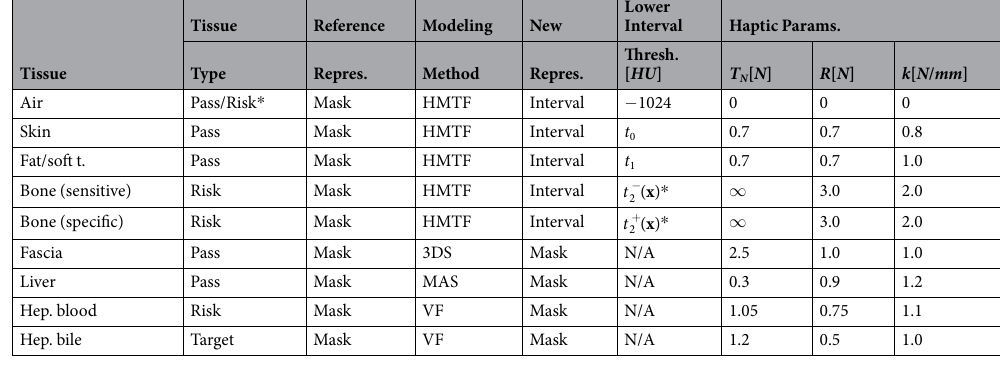
Table 1. Model representation and haptic parameters used for the main tissues. Acronyms: HMTF = Histogram Matched Transfer Function, 3DS = 3D-Spline-Surface, MAS = Multi-Atlas Segmentation, VF =